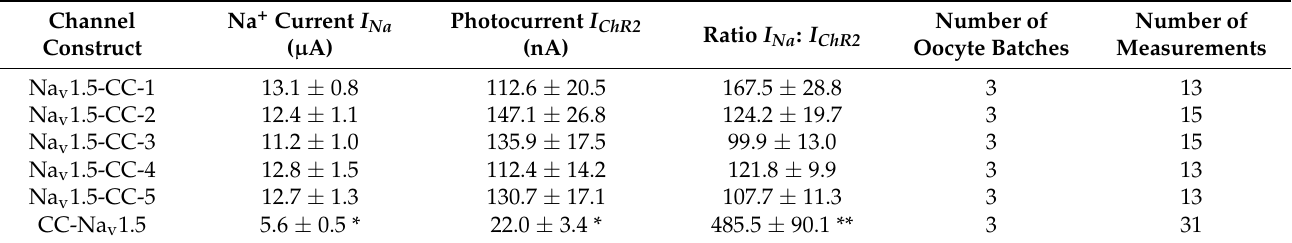
Table 1. Peak current amplitudes, I Na : I ChR2 ratios, and number of measurements in Xenopus laevis oocytes. The amount of cRNA injected per oocyte was about 5 ng. In these initial screening experiments, we used a single LED and a light pulse duration of 1